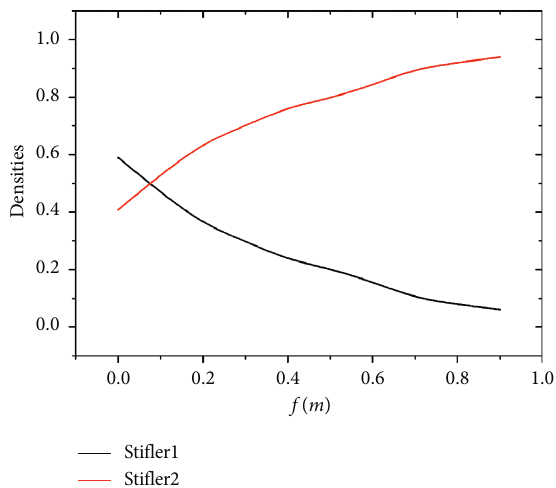
Figure 5: Density of stifler1 and stifler2 for different values of f ( m ) at steady state.